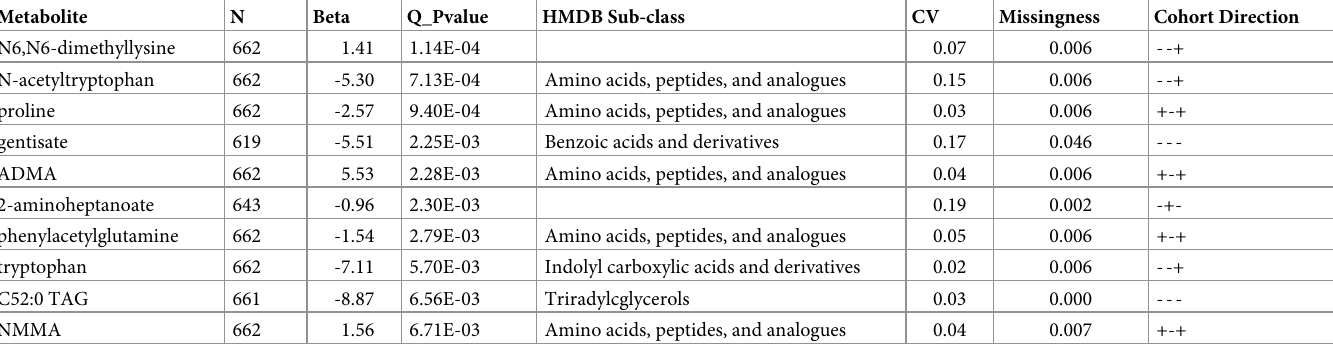
Table 4. Top 10 metabolites heterogeneous in effect among interventions from full